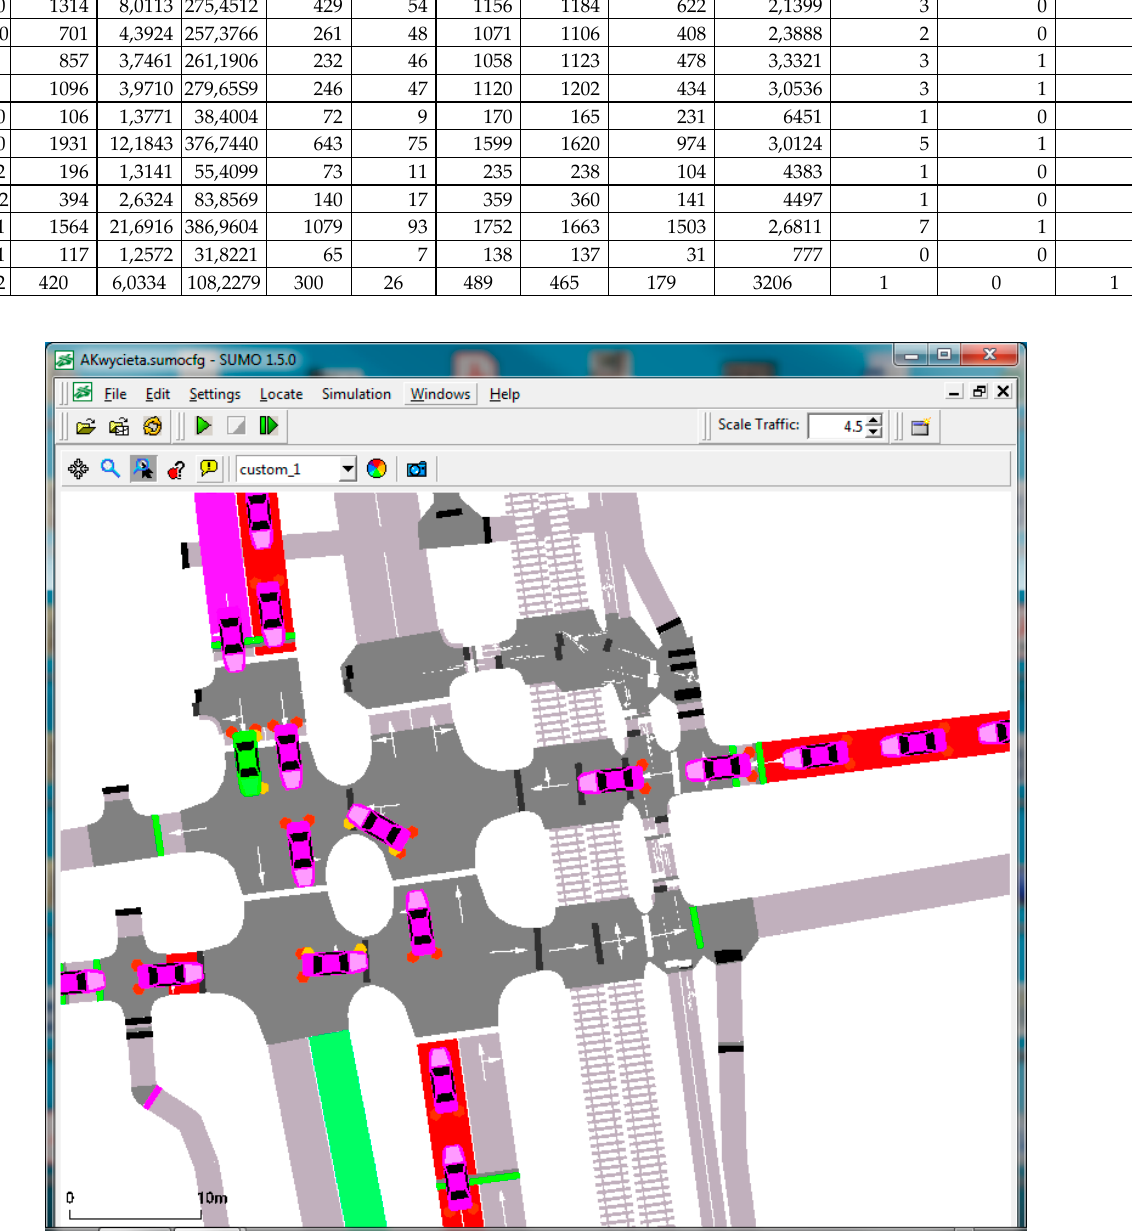
Figure 2. Visualization of pollution emissions. Table 4. Report on analysis of emission on lanes of the artery.